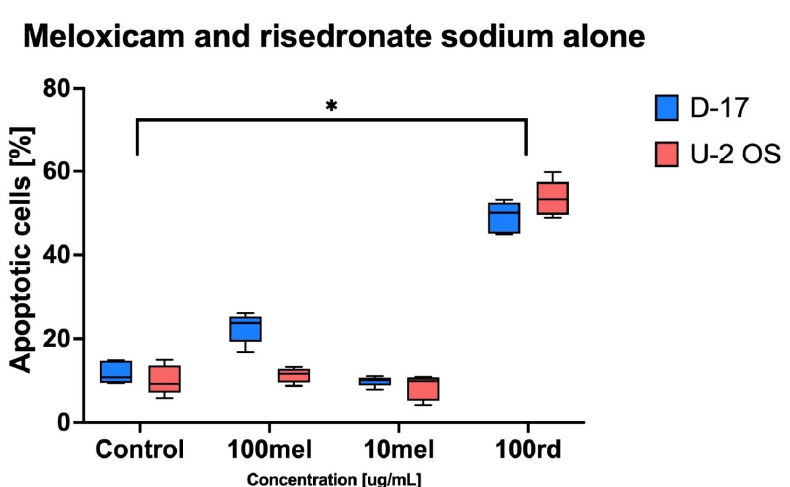
Figure 3. The apoptotic effect in canine (D-17) and human (U-2 OS) osteosarcoma triggered by risedronate sodium (rd) and meloxicam (mel) (* p < 0.05). The cytotoxic effect induced with 100 µg/mL of risedronate sodium proved statistically significant differences between both tested cell lines compared to the negative control (control). The results obtained with 10 and 100 µg/mL of meloxicam were not statistically significant. Figure 4 shows a combined, significant effect of meloxicam (100 and 10 µg/mL) and risedronate sodium (100 µg/mL) on apoptosis in the canine and human OS cell lines. The exposition of the cell lines to risedronate sodium (100 µg/mL) and meloxicam (100 µg/mL) resulted in the apoptosis rate of 83.43 ± 4.88 and 74.08 ± 7.29%, respectively. Additionally, for the ten-times lower concentration of meloxicam (10 µg/mL) and the same concentra- tion of risedronate sodium, the apoptosis was seen in around 60% of human and canine OS cells (60.17 ± 3.81 and 58.76 ± 6.17).